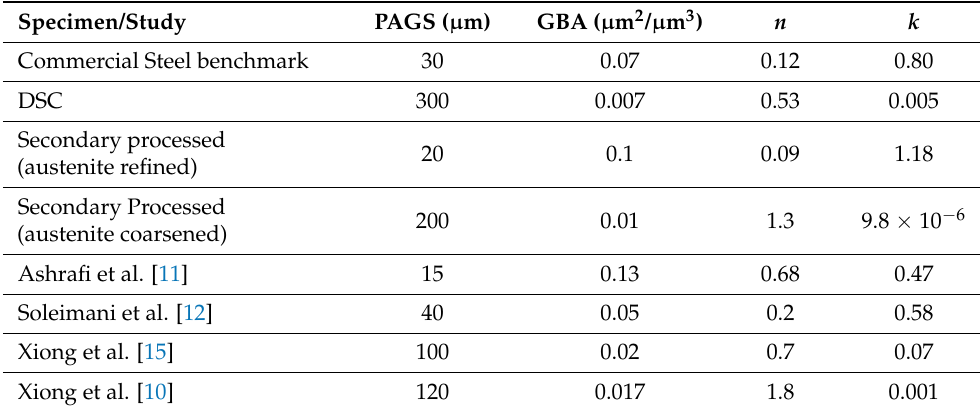
Table 2. Prior austenite grain size (PAGS) and grain boundary area (GBA) with JMAK parameters n and k . Parameters n and k have been normalised to an annealing temperature of 630 ◦